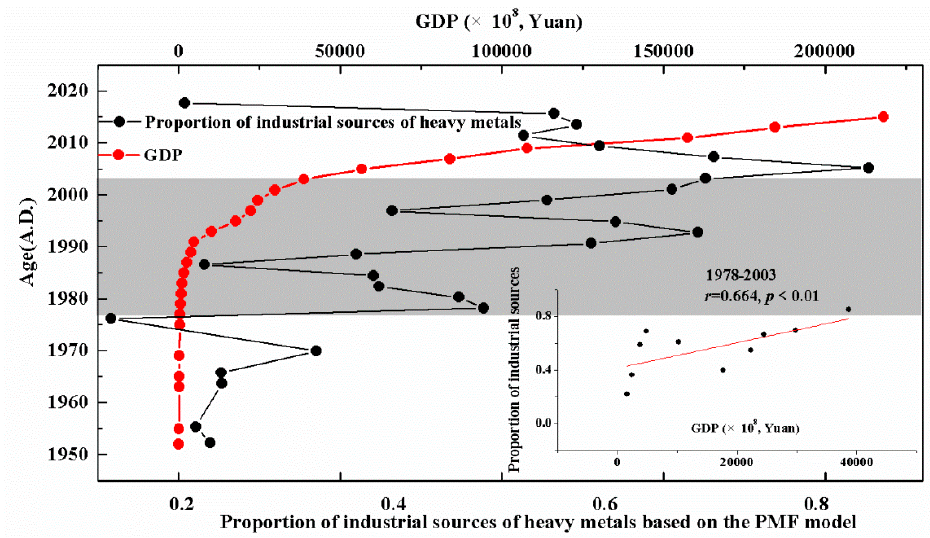
Figure 7. Correlation analysis of the proportion of industrial sources of heavy metals based on the PMF model and the GDP of the study area.